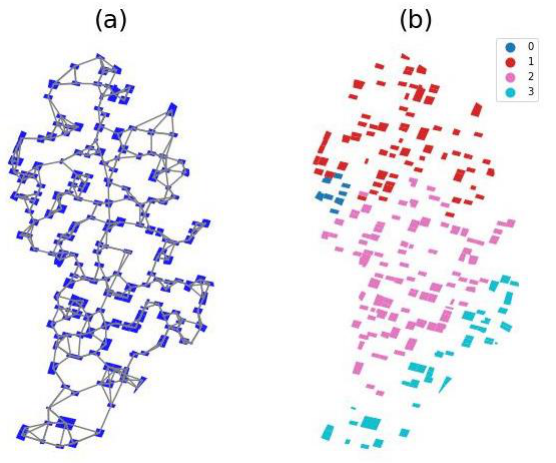
Figure 3. Hierarchical clustering with connectivity constraints. ( a ) Spatial distribution of houses and their connectivities with k = 3 NN. ( b ) Cluster structure with 4 regions or